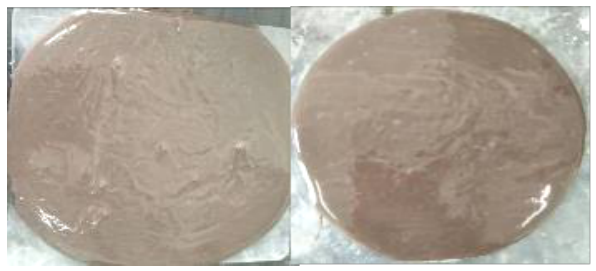
Figure 5: Soundness test cakes of the reconstructed steel